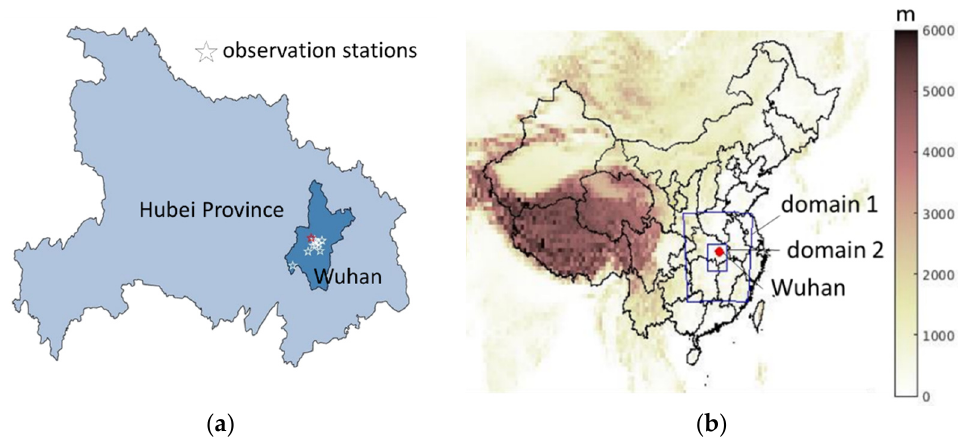
Figure 1. ( a ) Locations of 10 observation stations. The stars refer to 10 observations stations in Wuhan, including the representative Tianhe station (red star). ( b ) Model domains. The blue profile refers to terrain heights of the two nested model domains with horizontal resolutions of 10 km × 10 km (domain 1), 5 km × 5 km (domain 2). The red point is the location of Wuhan.